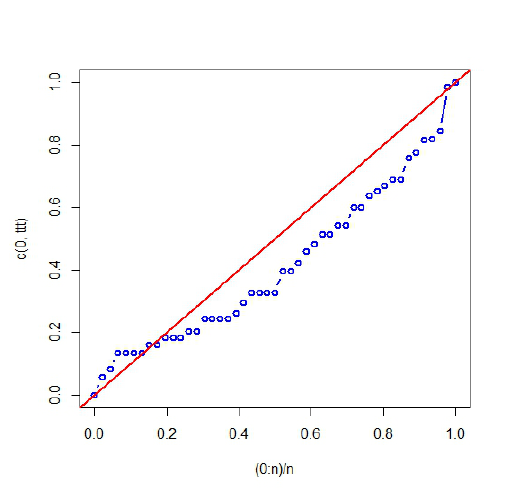
Figure 7 – TTT plot for data set.